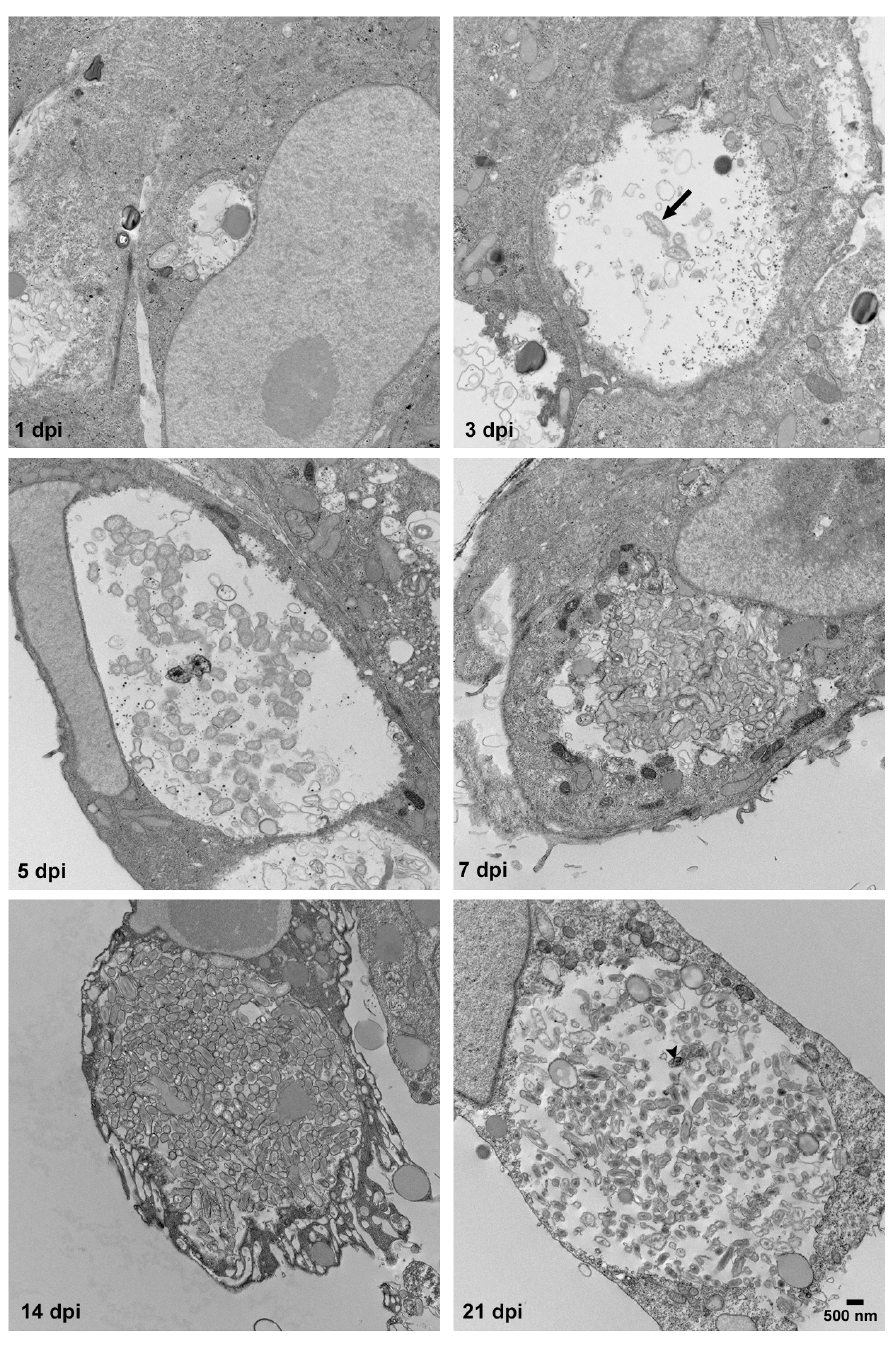
Fig 1. C . burnetii morphological development in Vero cells. Vero cell monolayers were incubated with purified SCV for 1 h to allow for adherence and internalization. Extracellular organisms were then washed from cell monolayers and fresh media added. Infected cells were fixed and processed for transmission electron microscopy at 1, 3, 5, and 7, 14, and 21 days post-infection (dpi). Prototypic LCV and SCV are designated in selected panels with an arrow and arrowhead, respectively. Bar, 500